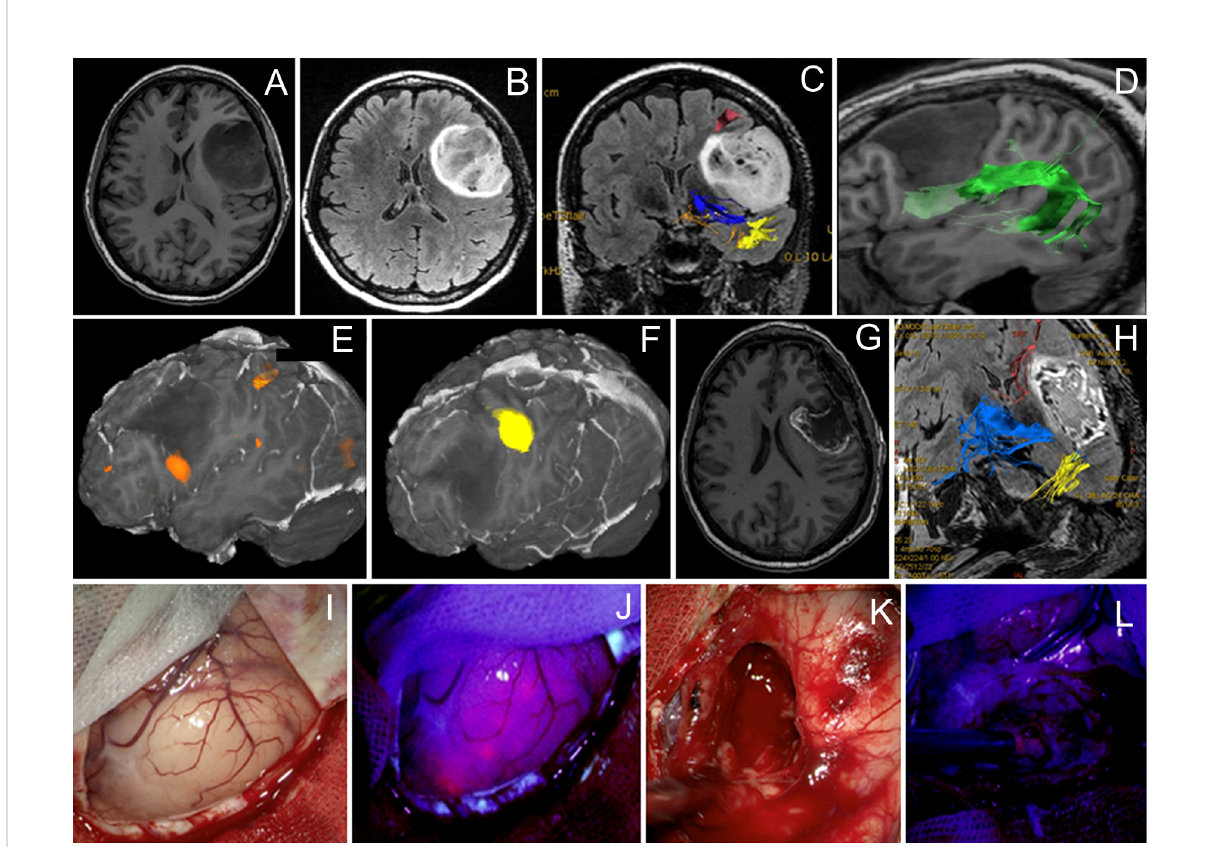
FIGURE 1 Case 1. A 40-year-old man with the left frontal anaplastic astrocytoma with mild residual fl uorescence at the end of resection. Preoperative axial T1-weighted (A) and Т 2 FLAIR (B) MR images demonstrate a clear tumor border. Functional MR images with reconstructed tracts show proximity of (C) the long-associative tracts (red — SLF I; blue — IFOF; yellow — ILF), (D) arcuate fasciculus (green), (E) Broca ’ s zone (orange) near the anterior – inferior tumor pole, and (F) motor arm cortex. (G) T1-weighted contrast-enhanced axial MR image 48 h after surgery demonstrating gross total resection (90%). (H) Coronal Т 2 FLAIR MR image taken within the fi rst 48 h after surgery shows long-associative tracts (blue — AF; yellow — ILF; orange — SLF). Intraoperative visualization of cortex in white mode (I) and BLUE400 mode (J) demonstrates light pink fl uorescence of the left frontal cortex. Images of tumor cavity under white light (K) and BLUE400 (L) demonstrate light pink fl uorescence of the residual tumor